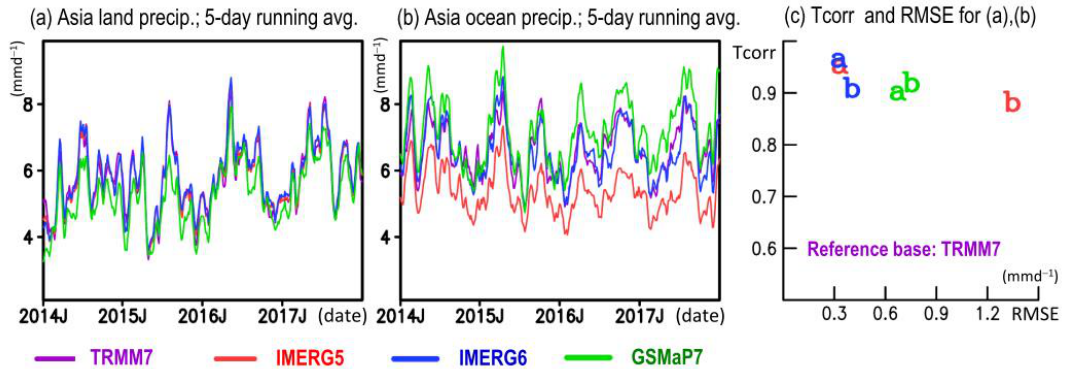
Figure 11. Time series of 5-day running averaged precipitation area-averaged over ( a ) the land and ( b ) the ocean of the Asian domain (60°E – 180°, 10°S – 40°N). The time series covered is from 2014 to 2017 JJAs (i.e., 368 days). ( c ) is based on ( a , b ), except for the calculation of Tcorr and RMSE between TRMM7 and the selected SPPs, including IMERG5 (red), IMERG6 (blue), and GSMaP7 (green).